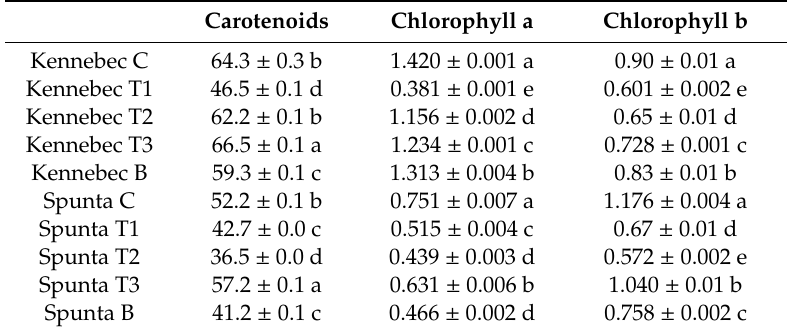
Table 7. Total carotenoids content and chlorophylls composition (mg / kg fw) of the studied potato varieties in relation to the fertilization